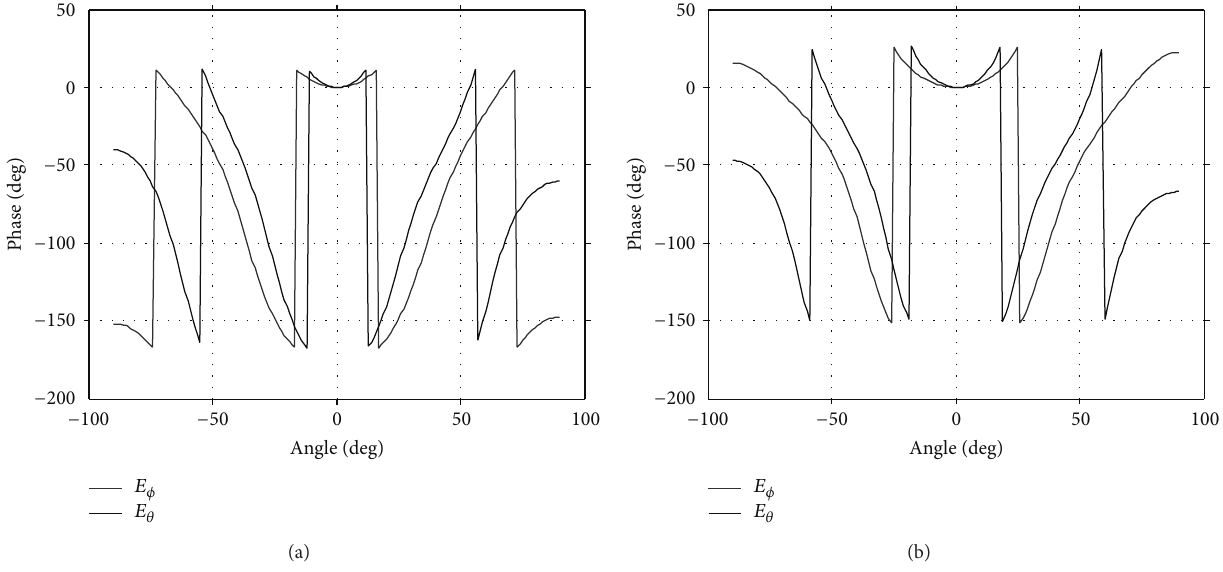
Figure 20: Comparison of phase radiation pattern of conical horn: (a) 𝑟 = 𝐷 2 /𝜆 , (b) 𝑟 = 2𝐷 2 /𝜆 .